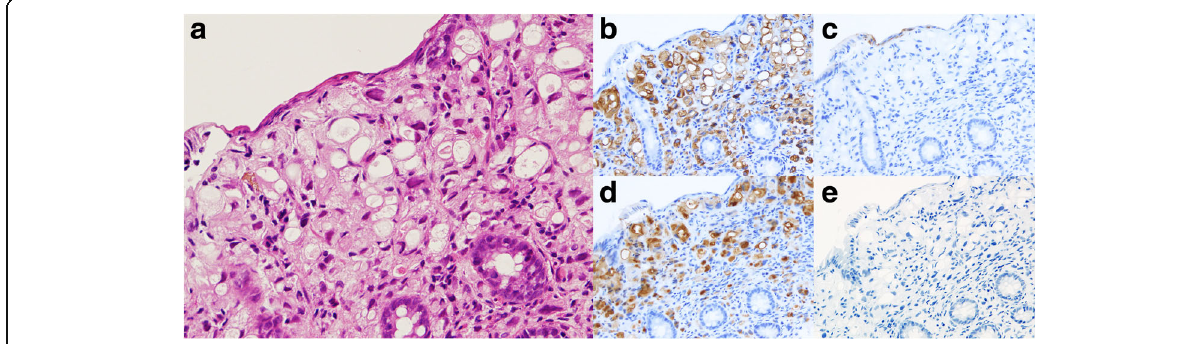
Fig. 3 Pathological findings of metastatic colonic polyp (HE). a Adenocarcinoma (signet-ring cell type) in the mucosa of the transverse colon (× 200). b – e The metastatic mucosal polyp was CK7 positive, CK20 negative, GCDFP-15 positive, and mammaglobin negative ( b , c , d , and e , respectively, × 200). These expressions corresponded to those of the primary breast cancer